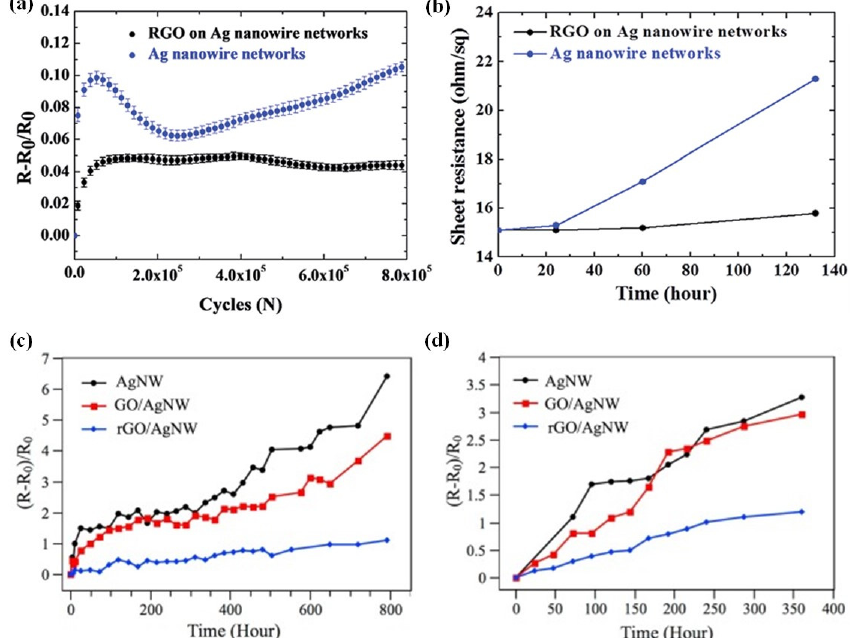
Figure 16. ( a ) Cyclic bending test results of silver nanowire networks with and without RGO coating after exposing them at 70 °C for 132 h. ( b ) Sheet resistance change of silver nanowire networks with and without RGO coating as a function of exposure time in air at 70 °C. Resistance change of bare silver nanowire networks with GO and RGO coatings exposed to air ( c ) at 120°C and ( d ) at 85 °C with 85% relative humidity. Reproduced with permission from ref. [49] with permission from The Royal Society of Chemistry. Reproduced with permission from ref. [50]. Copyright 2018, Elsevier.